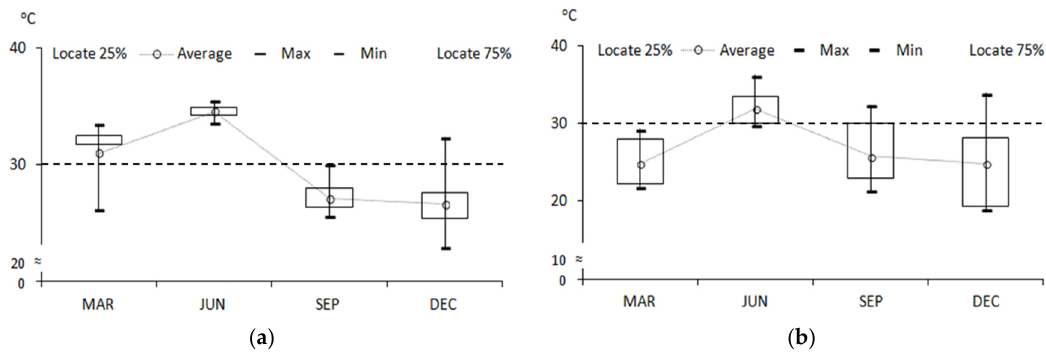
Figure 13. Seasonal events mPET variation by time for runners ( a ) and walkers ( b ).